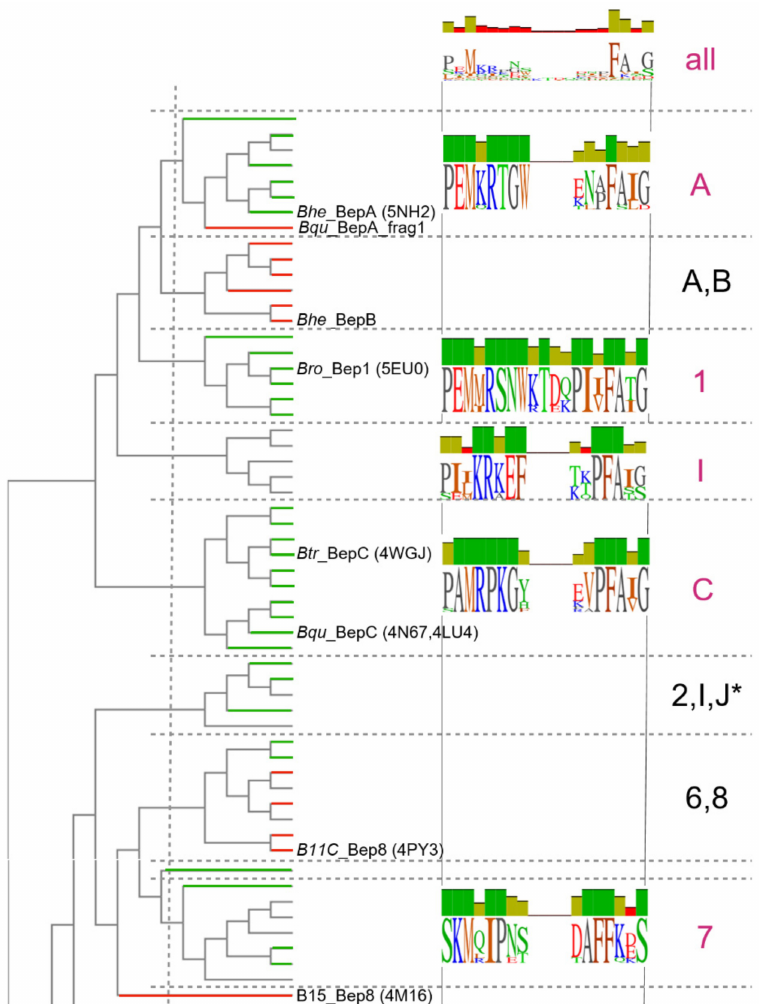
Figure 8. Excerpt of cladogram derived from BepFIC flap sequences with annotated sequence logos for selected branches. Horizontal lines colored in green or red indicate Beps with canonical FIC motif or with a glutamate in position G2 (groups b and d, respectively, in Figure 6B). The full cladogram with all logos and sequence names is shown in Figure S5. Branches were selected for being comprised of at least 5 members that have a pairwise identity score that is larger than the conservation score of the respective full-length sequence, see Figure S6. Branches are labeled according to the sub-clades of their members and the asterisk indicates the additional presence of Ban members (lineage